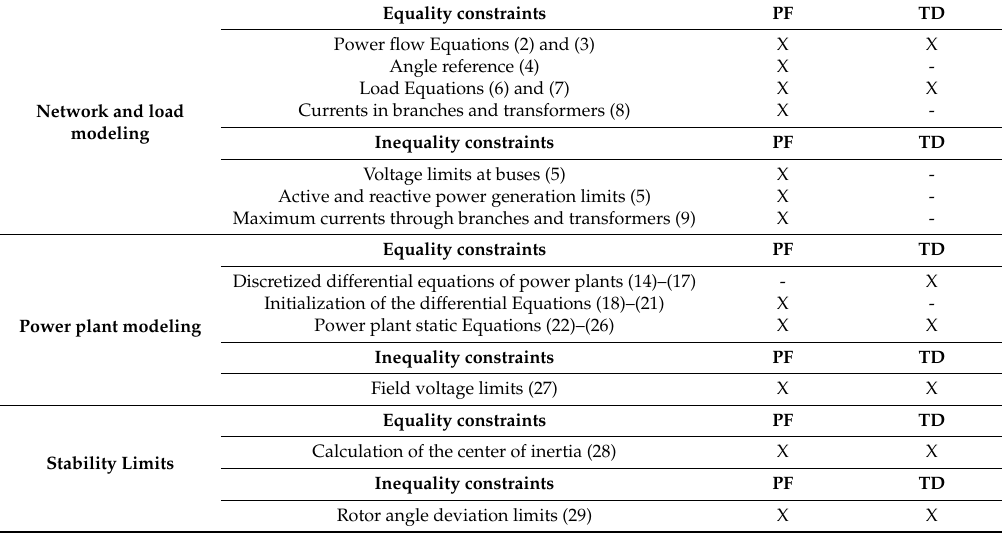
Table 1. Summary of the constraints of the optimization